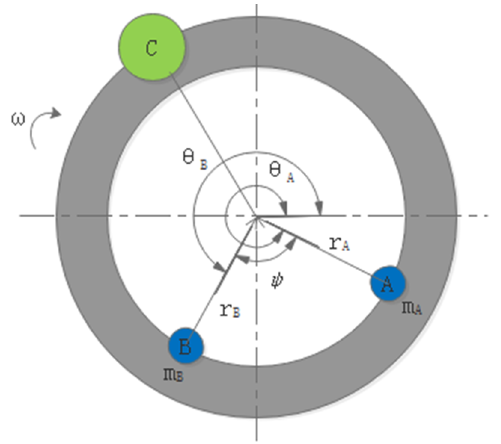
Figure 2. Mechanical model of double counterweight balance.